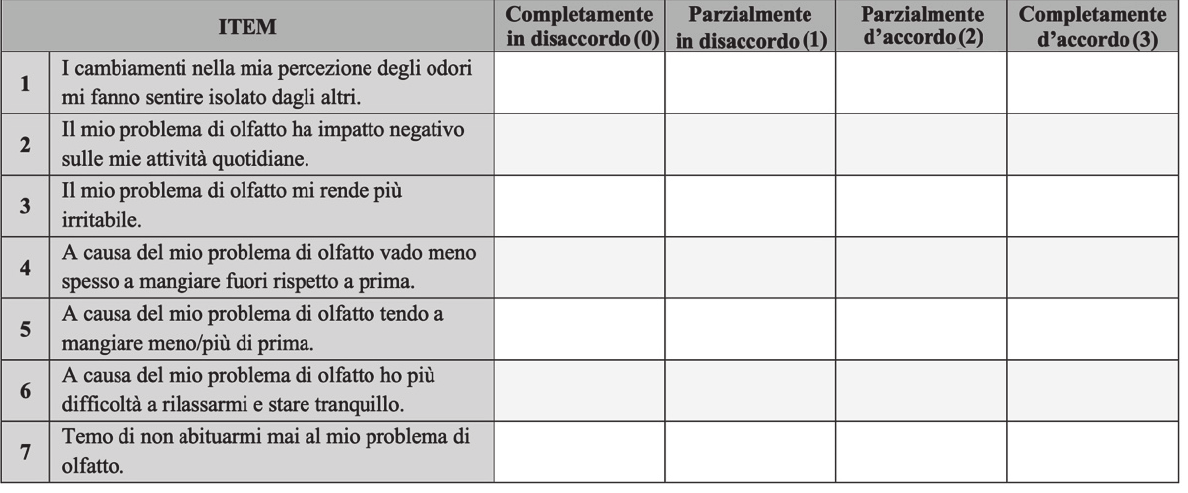
Figure 3. Italian version of Questionnaire of Olfactory Disorders—Negative Statements (ITA svQOD ‐ NS) .